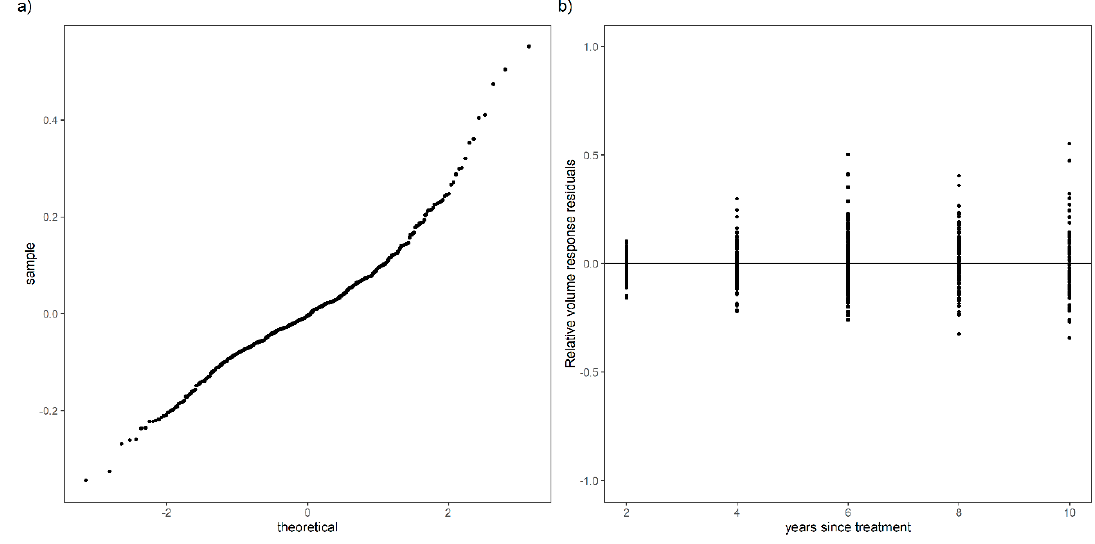
Figure 7. Quantile-quantile plot showing the normality of the residuals ( a ); Residuals over time ( b ) do not display a trend.